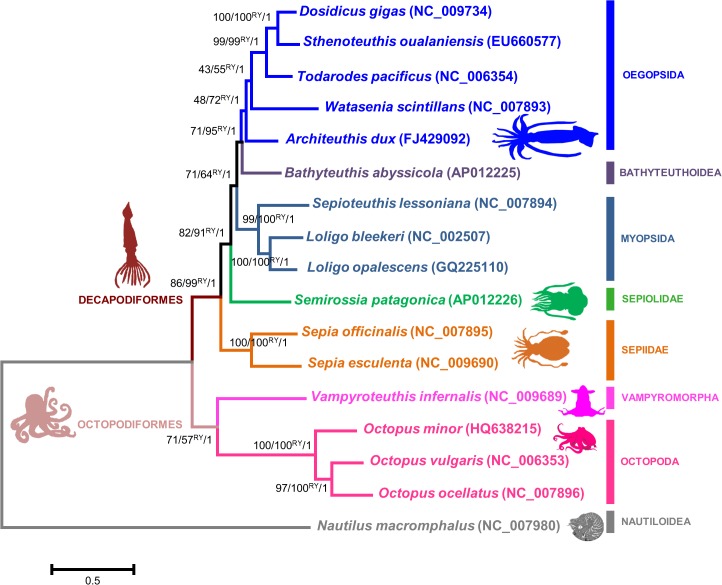
Cephalopoda mitogenomic consensus phylogenetic tree.The topology shown corresponds to the Maximum likelihood (ML) tree. The bootstrap probabilities (%) supporting each node were estimated with ML analyses using PHYML software version 3.0 (1000 bootstrap replicates, GTR+G+I model and best of NNI&SPR branch search algorithm) and are shown by the first and second values next to the branches. The RY symbol indicates that these values resulted from the RY coded alignments. The posterior probability supporting each node was estimated from Bayesian analyses using MRBAYES (GTR+G+I model; 10 000 000 generations; a sample frequency of 100 and a burn-in corresponding to 25% of the sampled trees) and corresponds to the third value next to the branches. The tree is drawn to scale, with branch lengths measured in the number of substitutions per site. Superorders–Decapodiformes (10 arms) and Octopodiformes (8 arms). The species are designated by their scientific names followed by the respective accession numbers. On the right, are indicated the names of the major taxonomic groups of cephalopods.